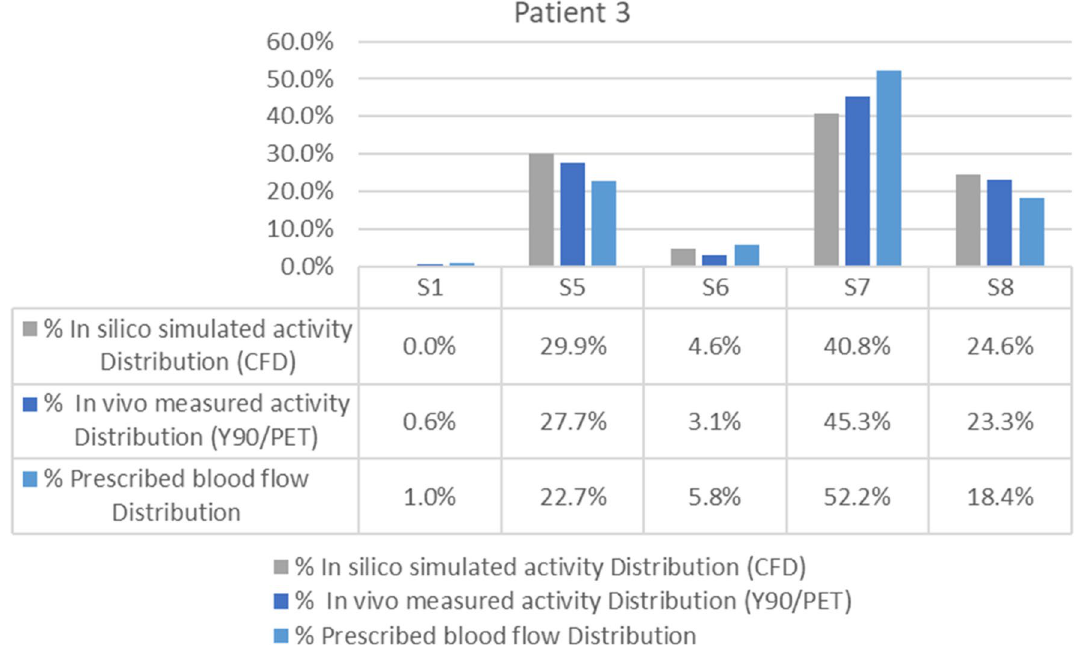
Figure 7. Segment-to-segment calculated activity distribution (CFD), measured activity distribution ( 90 Y/PET), and prescribed blood flow split for Patient 3.